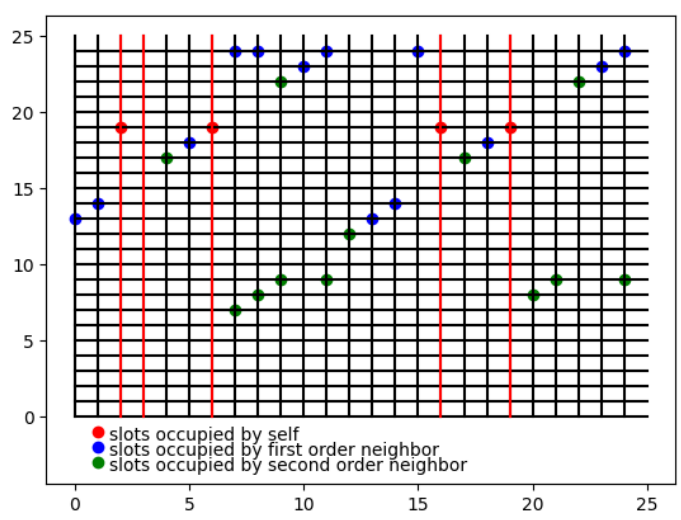
Figure 11. The final situation of slots occupied in the sub-network centered by Node 19. The hor- izontal direction denotes the IDs of slots, while the vertical direction indicates the IDs of nodes. The red dots represent slots occupied by Node 19. The blue dots indicate slots occupied by first-order neighbors of Node 19, and the green dots second-order neighbors. From the red line, it is obvious that the slots occupied by Node 19 are not occupied by any of its first- or second-order neighbors, and thus communication collisions will not occur when Node 19 speaks. Meanwhile, all slots have already been occupied by at least one node, indicating that Node 19 has already occupied all available slots.